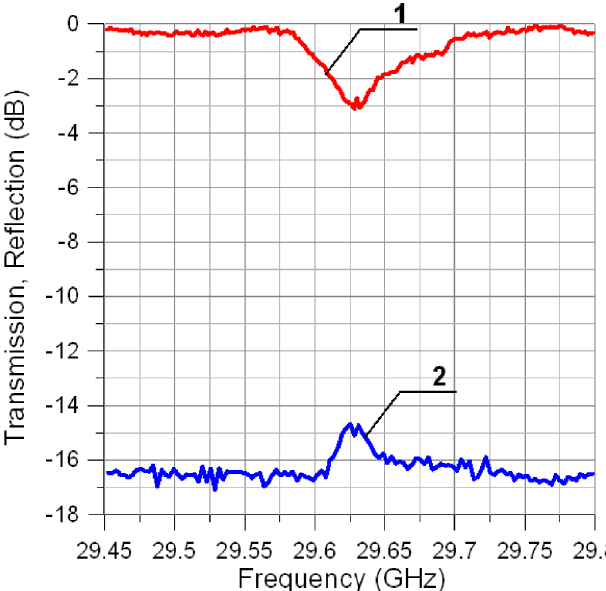
FIG. 15. (Color) Transmission (curve 1) and reflection (curve 2) of the tested pulse